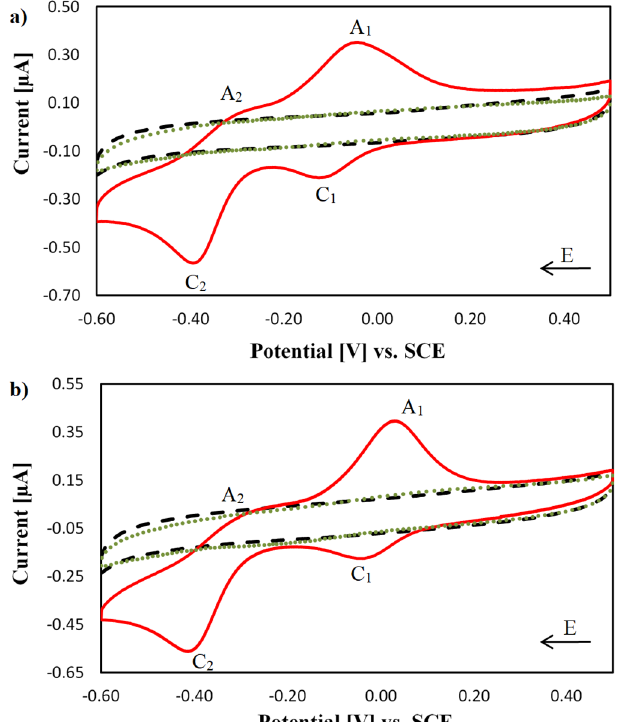
Figure 3. Typical cyclic voltammograms registered at the DNA biosensors, in 0.1 M PB, pH 7.0, scan rate 100 mV s − 1 (black dashed trace), in 20 μ M of ( a ) [Cu(TPMA)(phen)] 2+ ( b ) [Cu(TPMA)(DPQ)] 2+ (red solid trace) and after washing the complex from the DNA layer for 1 h (green dotted trace). The [Cu(TPMA)(DPQ)] 2+ C 1 /A 1 redox couple is shifted to less negative